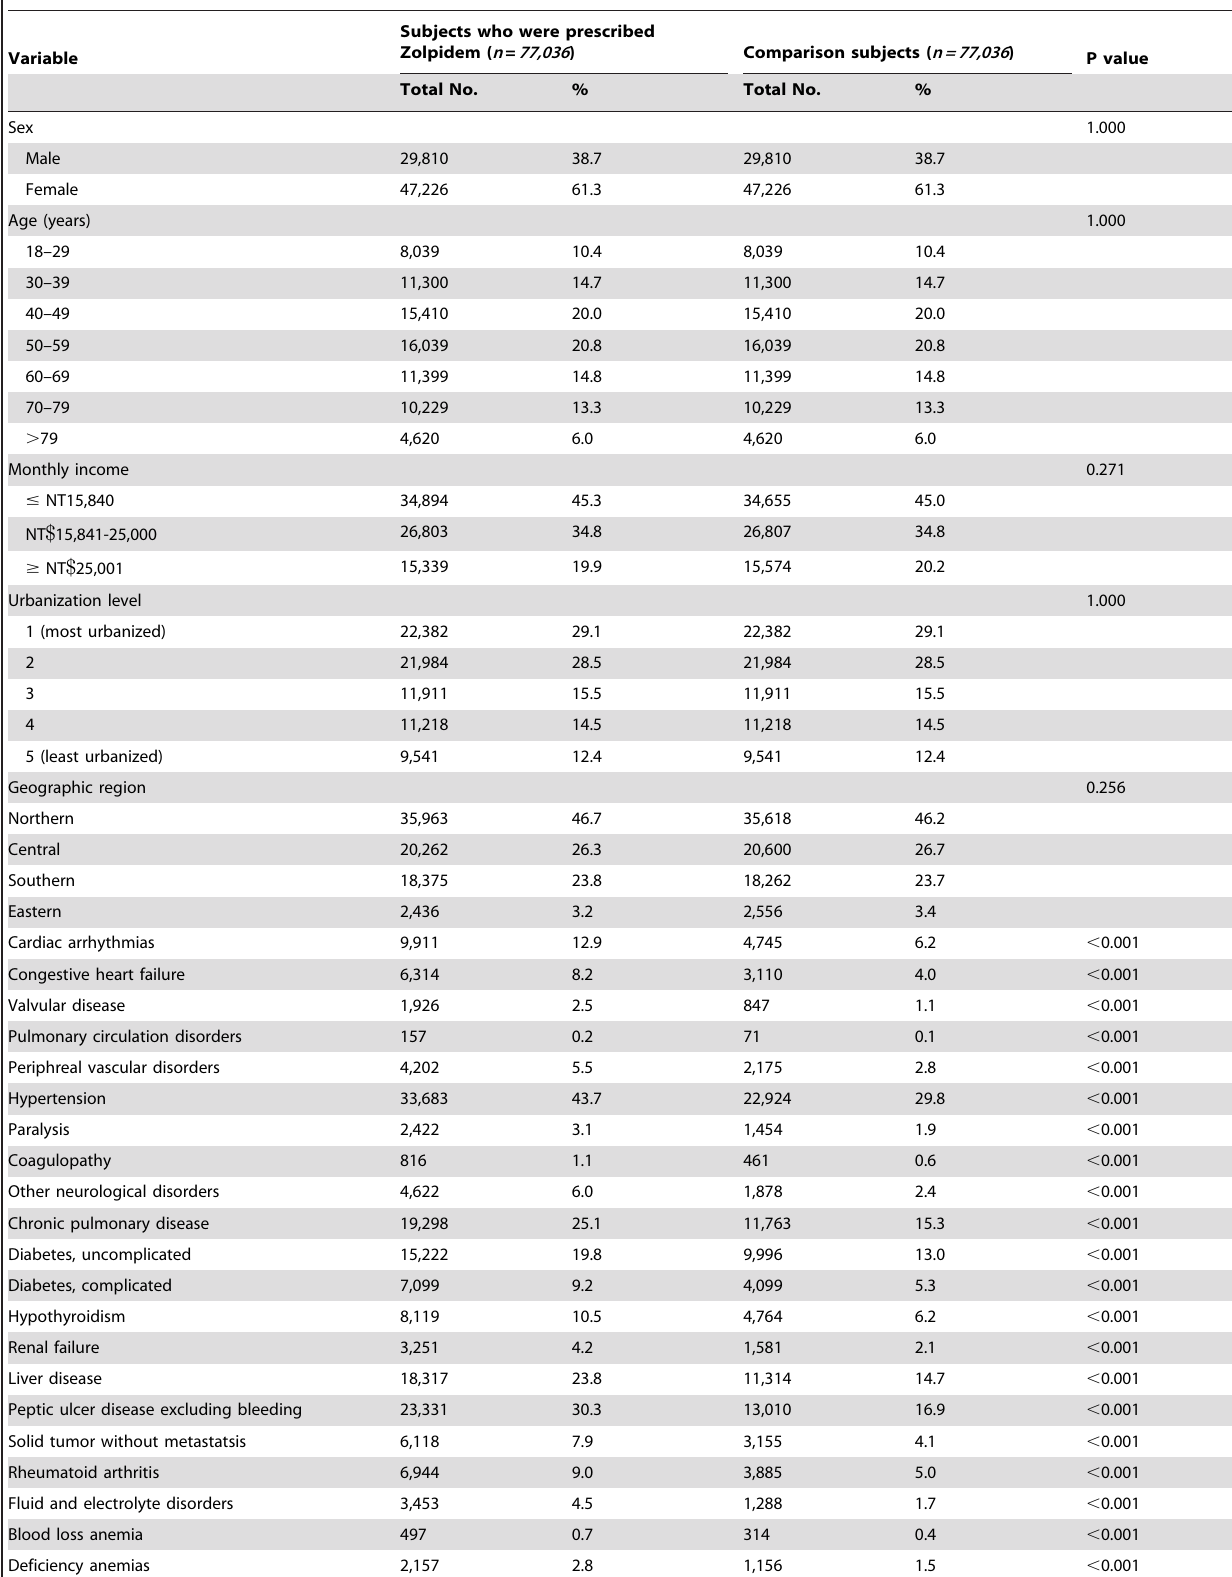
Table 1. Comparisons of sociodemographic characteristics of subjects who were prescribed Zolpidem and comparison subjects, 2005–2007 (n= 154,072).